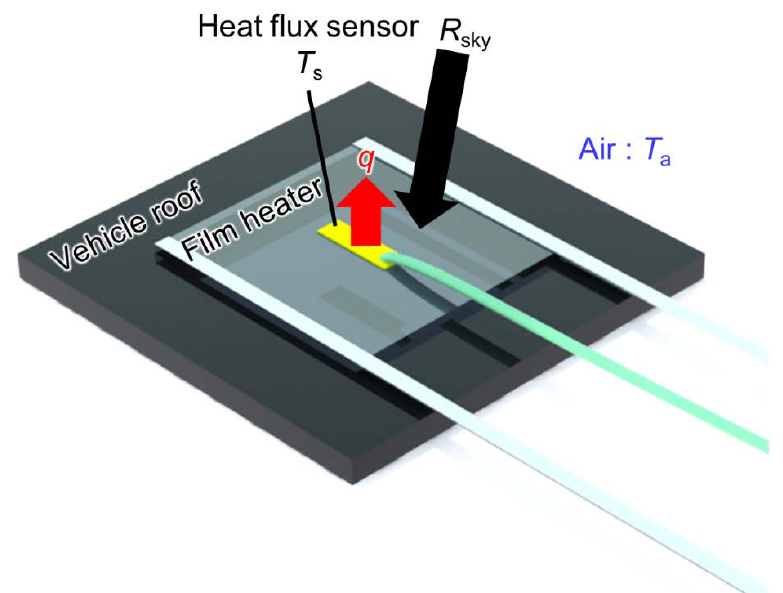
Figure 4. Measurement system at each heat flux sensor position. Heat flux sensor temperature T s ; net heat flux q ; infrared (IR) thermal radiation flux from the sky R sky ; air temperature T a .